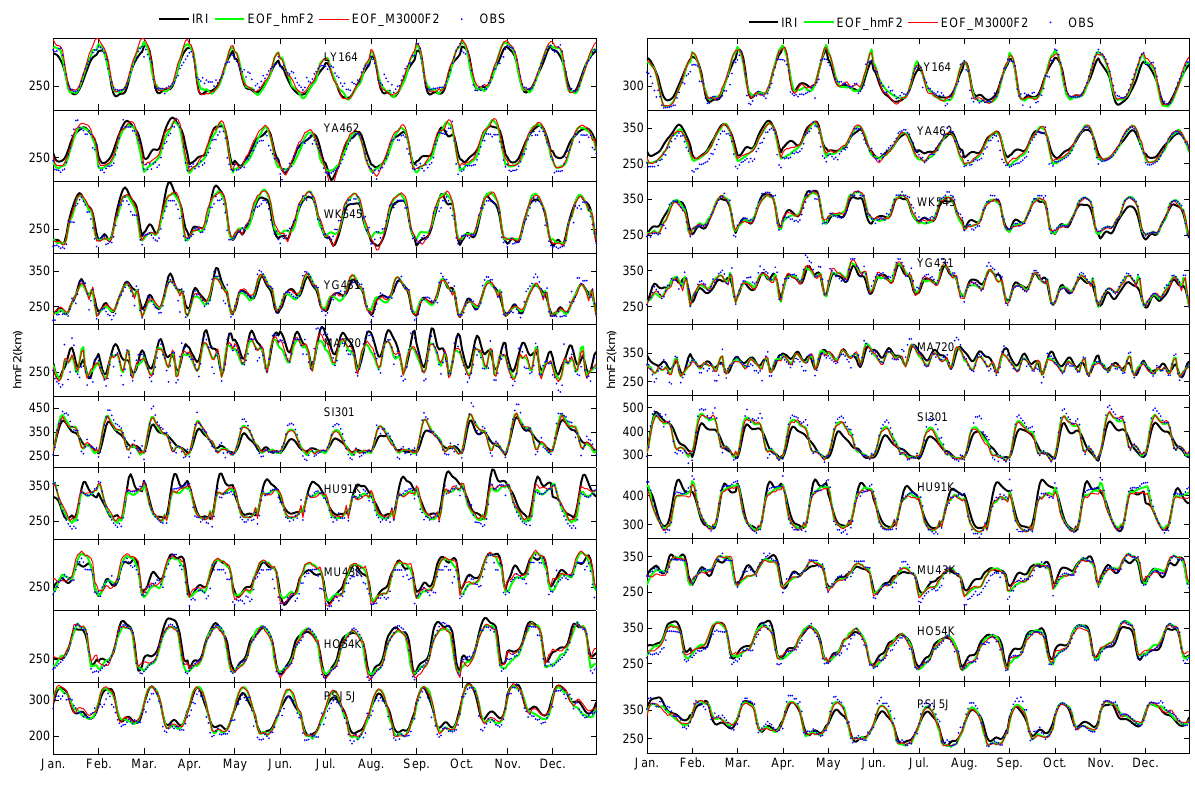
Fig. 7. Sample plots of model values and observational data of hm F2 for the years of (a) 1965 and (b) 1970. From top to bottom panels, stations are ordered from north high, middle and low latitudes to the south low, middle and high latitudes.